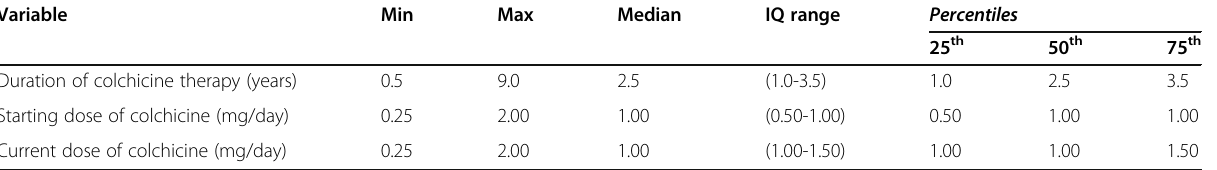
Table 3 Duration, starting dose, and current dose of colchicine therapy among cases Variable